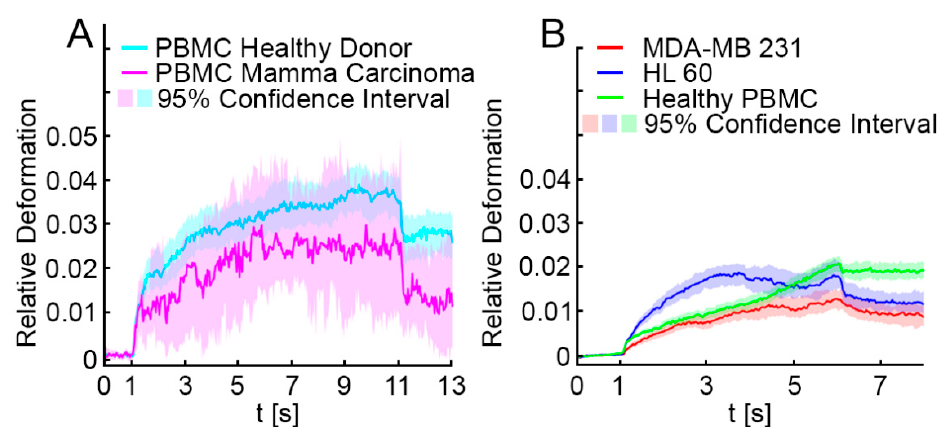
Figure A1. Elliptic deformation curves of blood cells, MDA-MB 231 and HL-60. ( A ) CD45 positive PBMC from healthy donors (cyan line, n = 3) showed the same elliptic deformation as CD45 positive PBMC from breast cancer patients (magenta line, n = 2) at 1200 mW. ( B ) MDA-MB 231 (red line), HL-60 (blue line) and CD45 positive PBMC (green line) were significantly different in terms of their elliptic deformation ( p < 0.001) at 875 mW.